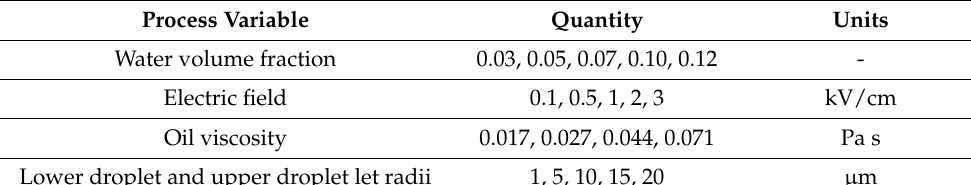
Table 3. Levels of the variables considered in this work to perform the process